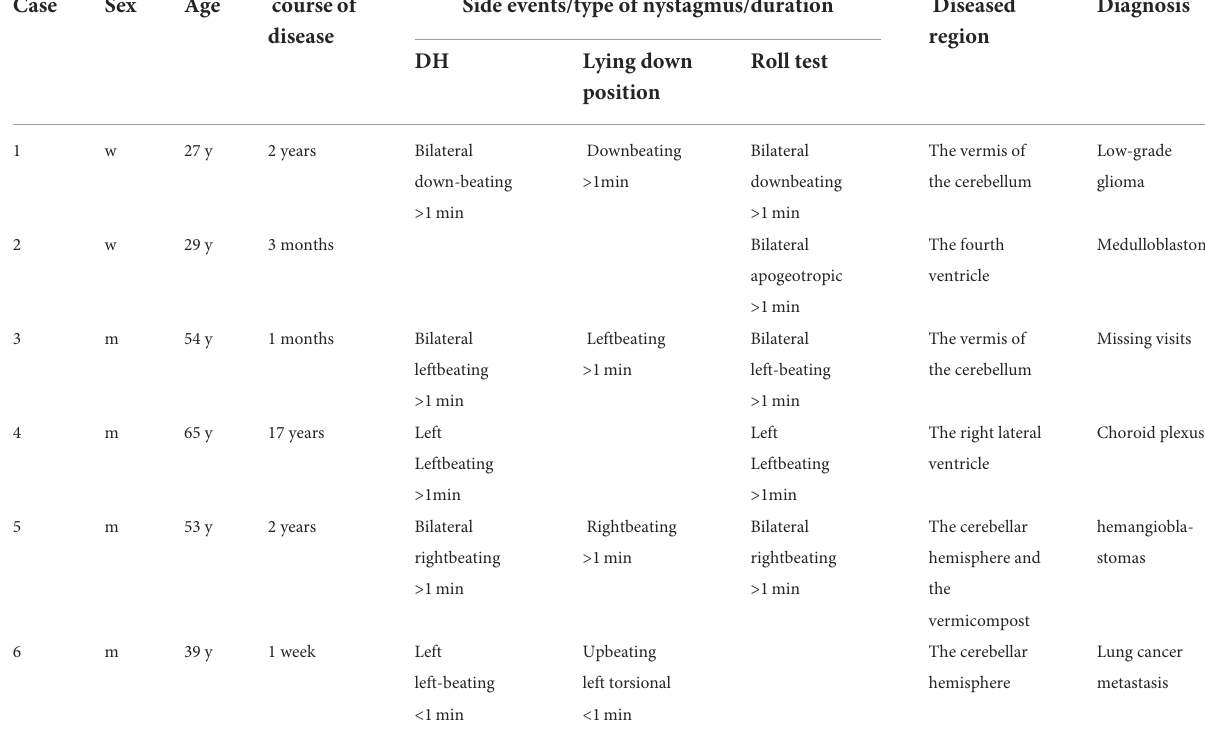
TABLE 1 Clinical data of six intracranial tumor